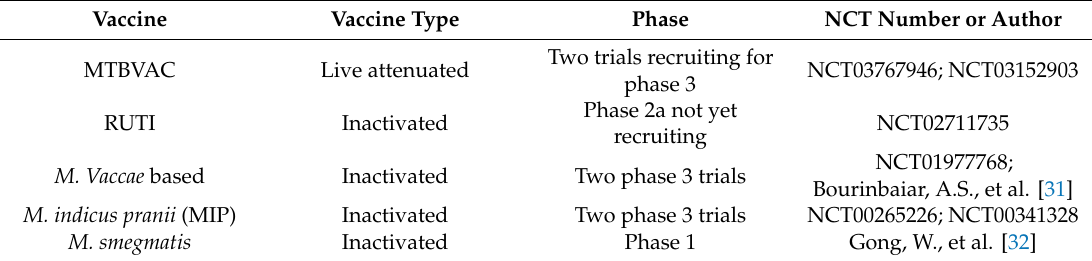
Table 1. Live attenuated, inactivated, and subunit / adjuvant vaccines in clinical